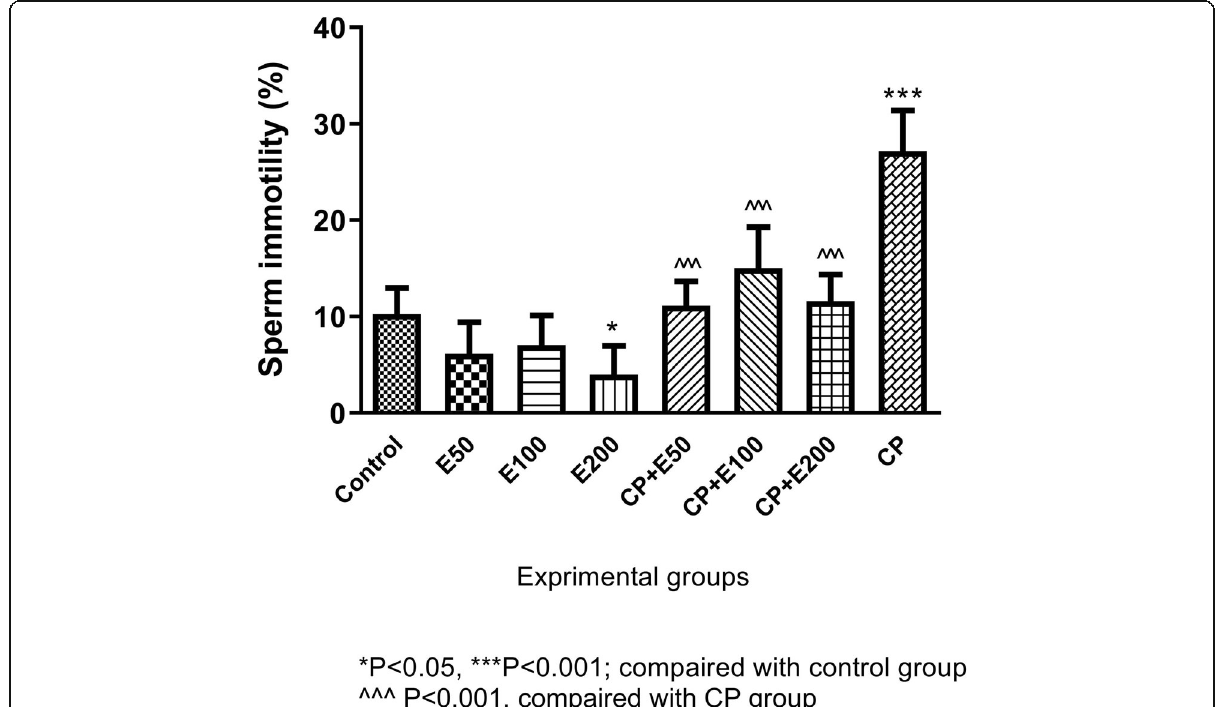
Fig. 3 The effect of Allium atroviolaceum L. extract (E) on sperm immotility in cyclophosphamide (CP)-treated mice